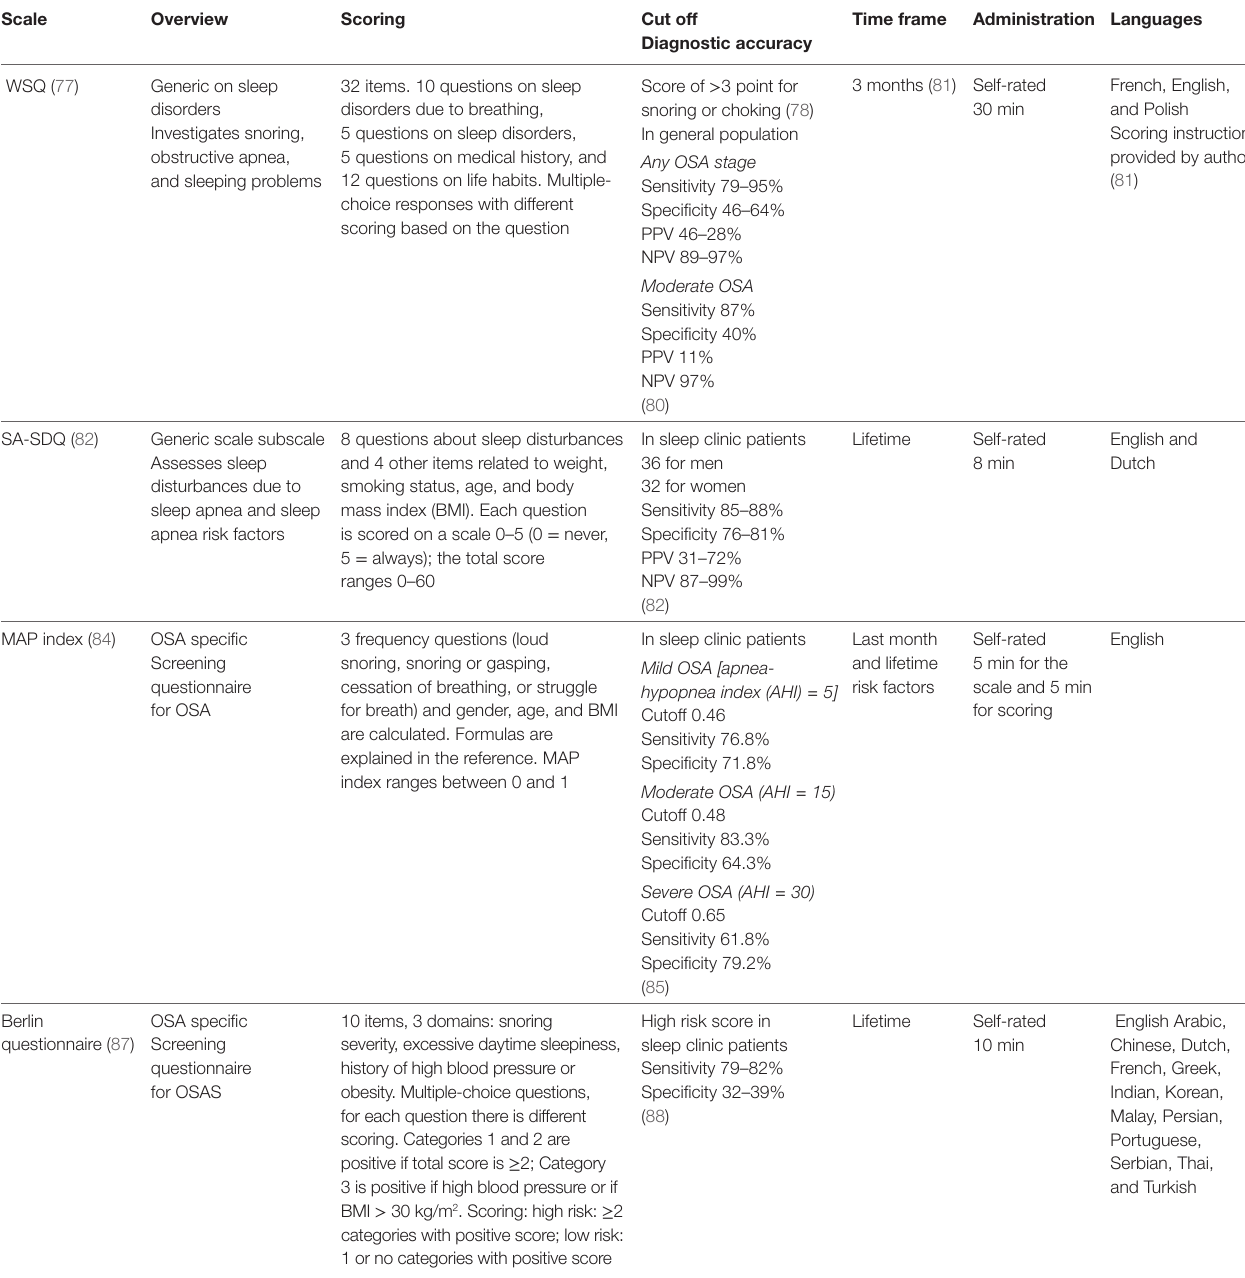
TABLe 3 | Scales that evaluate obstructive sleep